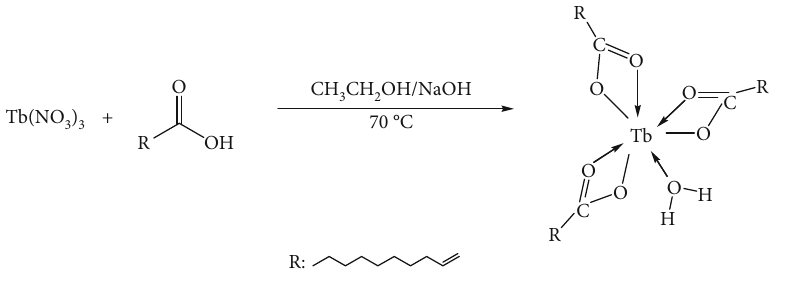
Figure 1: The synthetic route of the 10-UA-Tb(III)